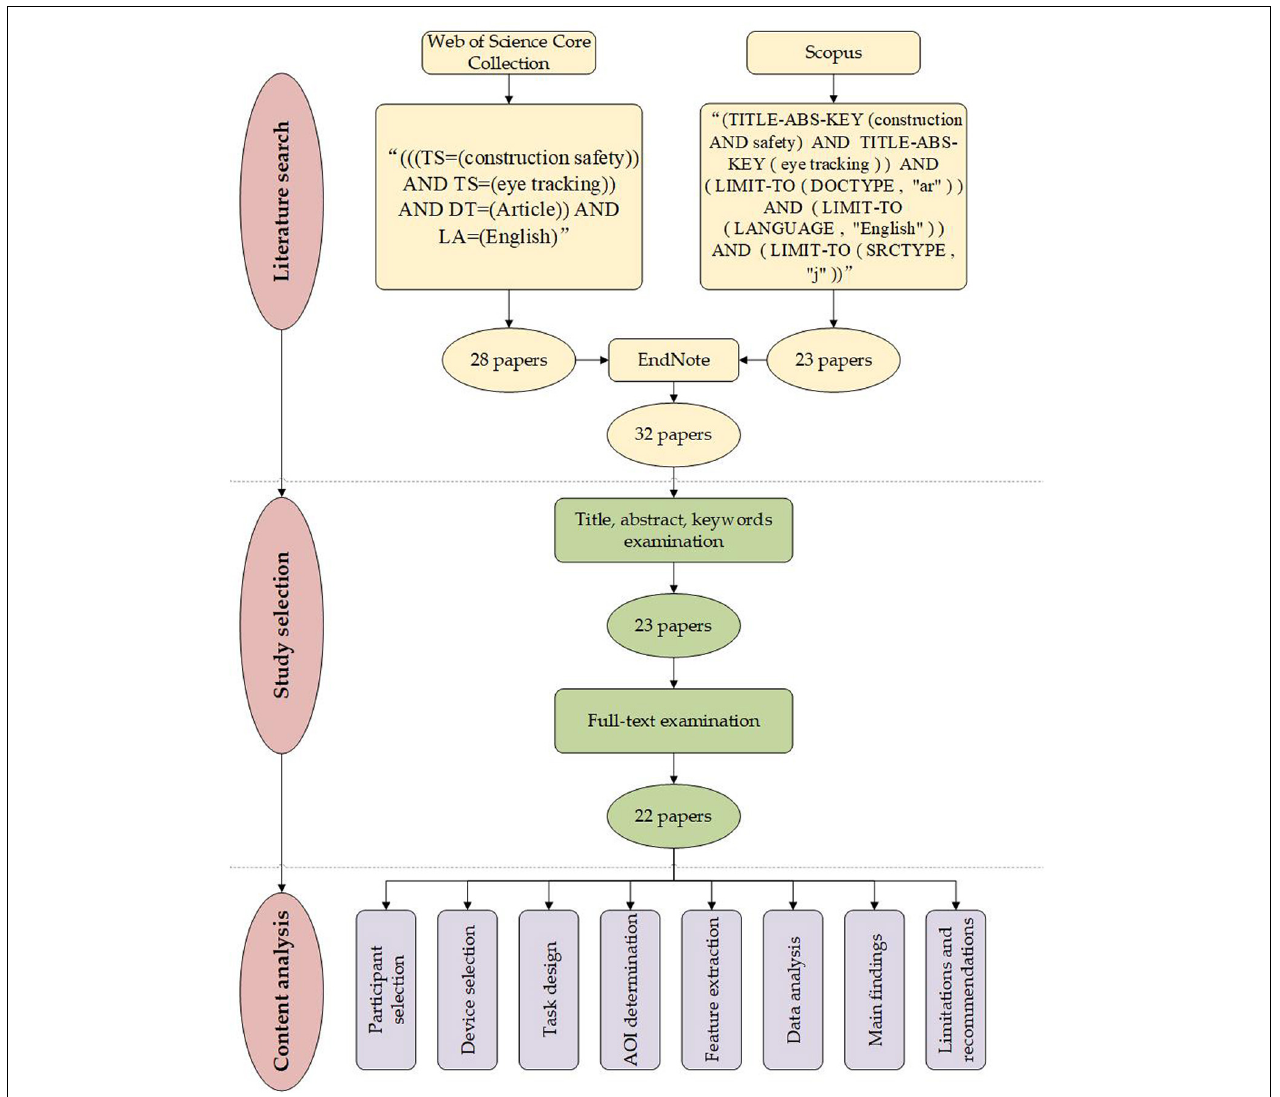
FIGURE 1 | Overview of review